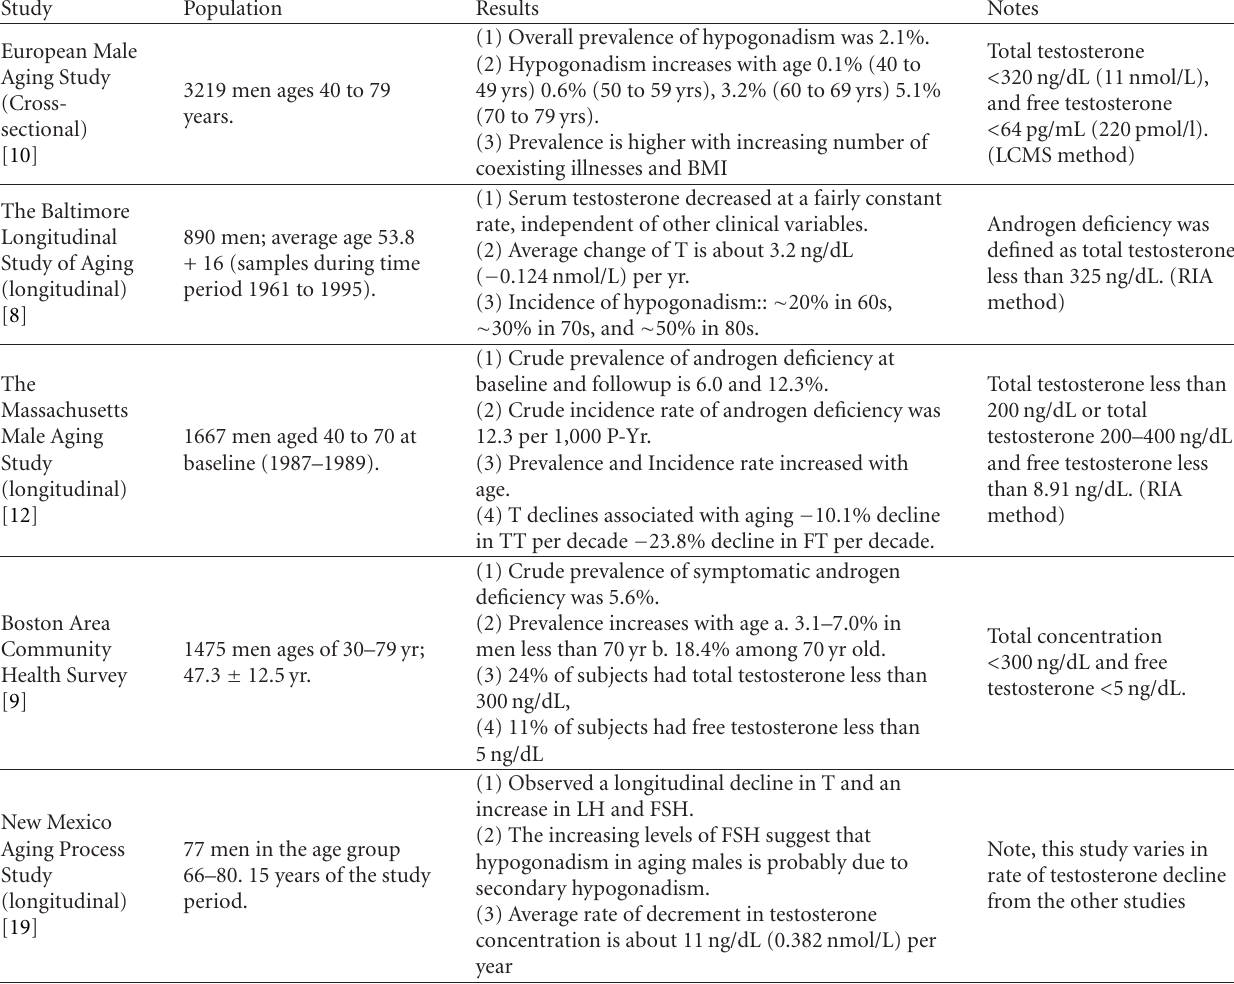
Table 1: Cross-Sectional and Longitudinal Studies of Hypogonadism in Aging